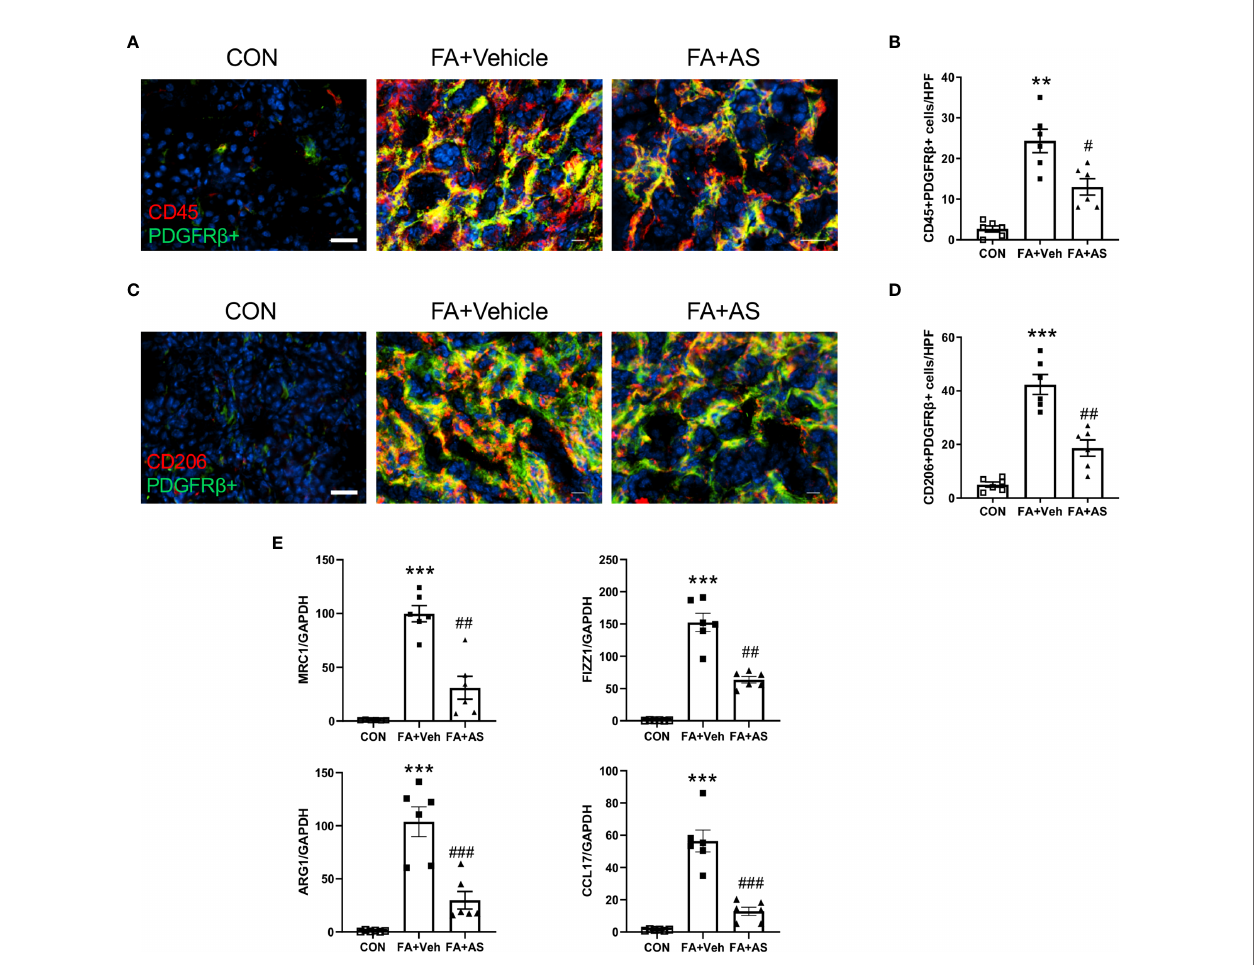
FIGURE 6 | AS1517499 attenuates myeloid fi broblast accumulation and macrophage polarization in folic acid nephropathy. (A) Representative photomicrographs of kidney sections 2 weeks after vehicle or AS1517499 treatment stained for CD45 (red), PDGFR- b (green), and DAPI (blue). Scale bar, 50 m m. (B) Quantitative analysis of CD45 + and PDGFR- b + fi broblasts in the kidney. ** P < 0.01 vs CON. # P < 0.05 vs FA+Veh. n = 6 per group. (C) Representative photomicrographs of kidney sections 2 weeks after vehicle or AS1517499 treatment stained for CD206 (red), PDGFR- b (green), and DAPI (blue). Scale bar, 50 m m. (D) Quantitative analysis of CD206+ and PDGFR- b + fi broblasts in the kidney. *** P < 0.001 vs CON. ## P < 0.01 vs FA+Veh. n = 6 per group. (E) Quantitative analysis of mRNA expression of M2 macrophage makers (MRC, FIZZ1, Arg1, CCL17) in the kidney 2 weeks after vehicle or AS1517499 treatment. *** P < 0.001 vs CON; ### P < 0.001 vs FA+Veh; ## P < 0.01 vs FA+Veh. n = 6 per